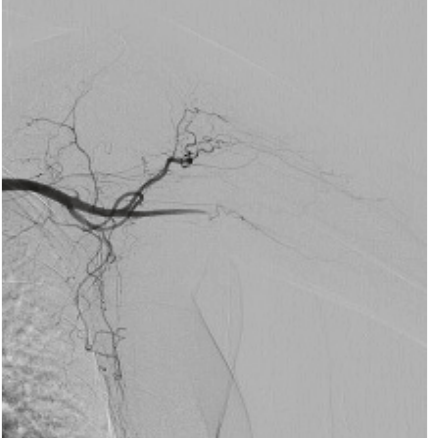
Figure 2: Pallor of the distal fingers of the right hand.